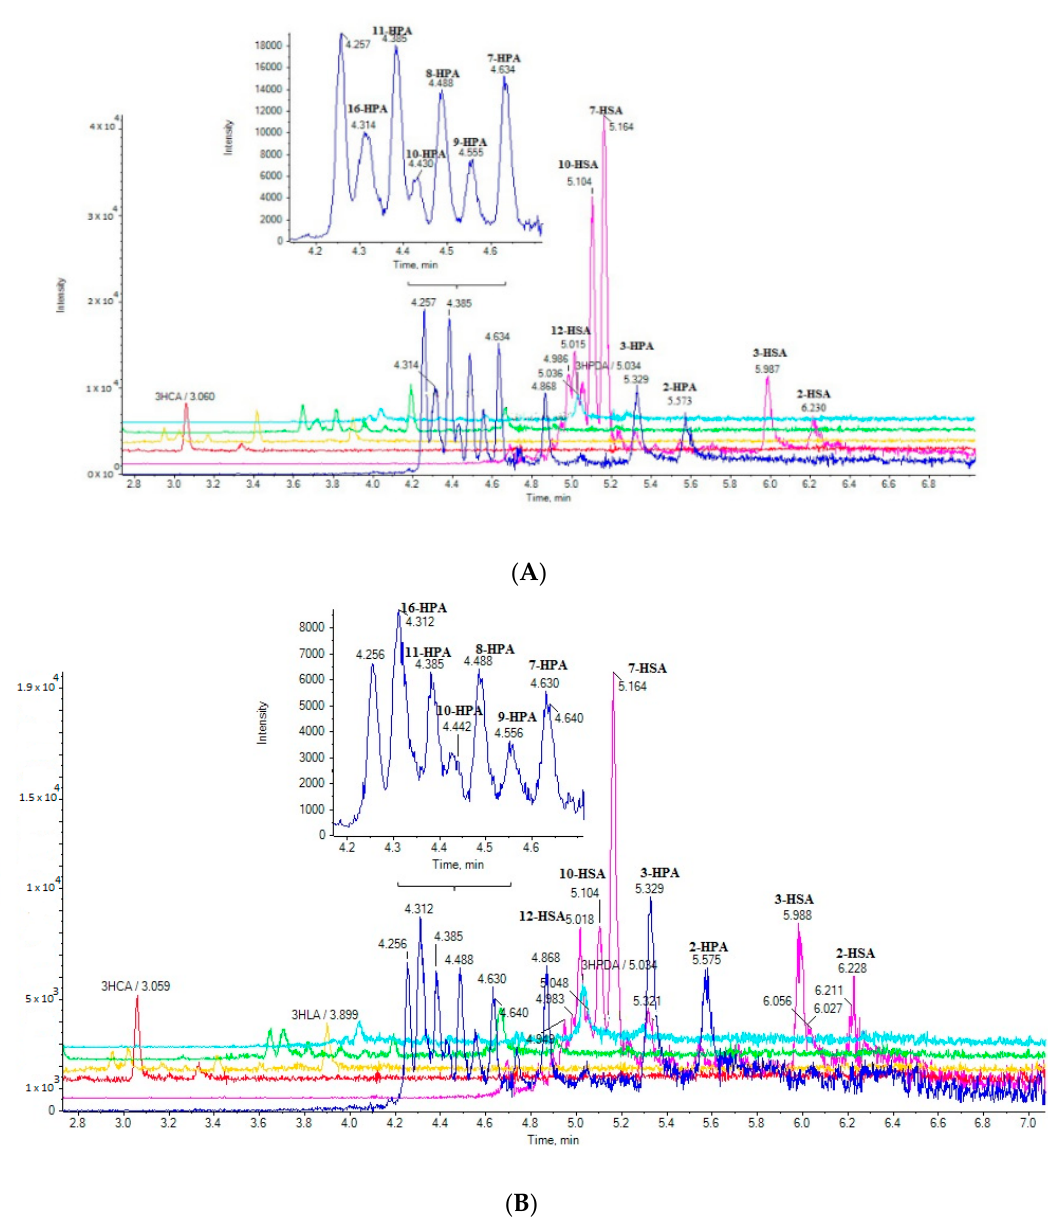
Figure 2. EICs of the analytes in a cow milk sample ( A ) and in a goat milk sample ( B ).